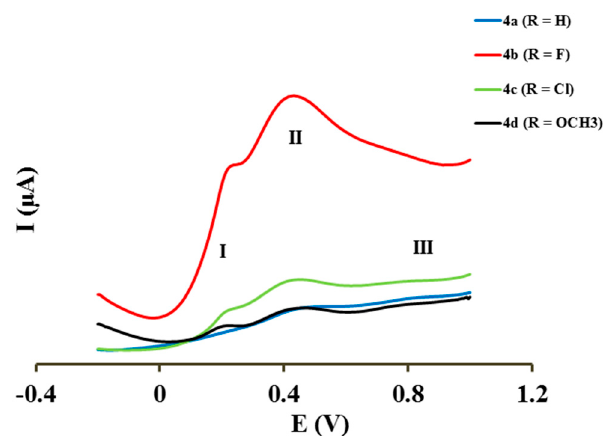
Figure 11. Square-wave voltammograms of (Ir( 4a – d ) 3 ) complexes.